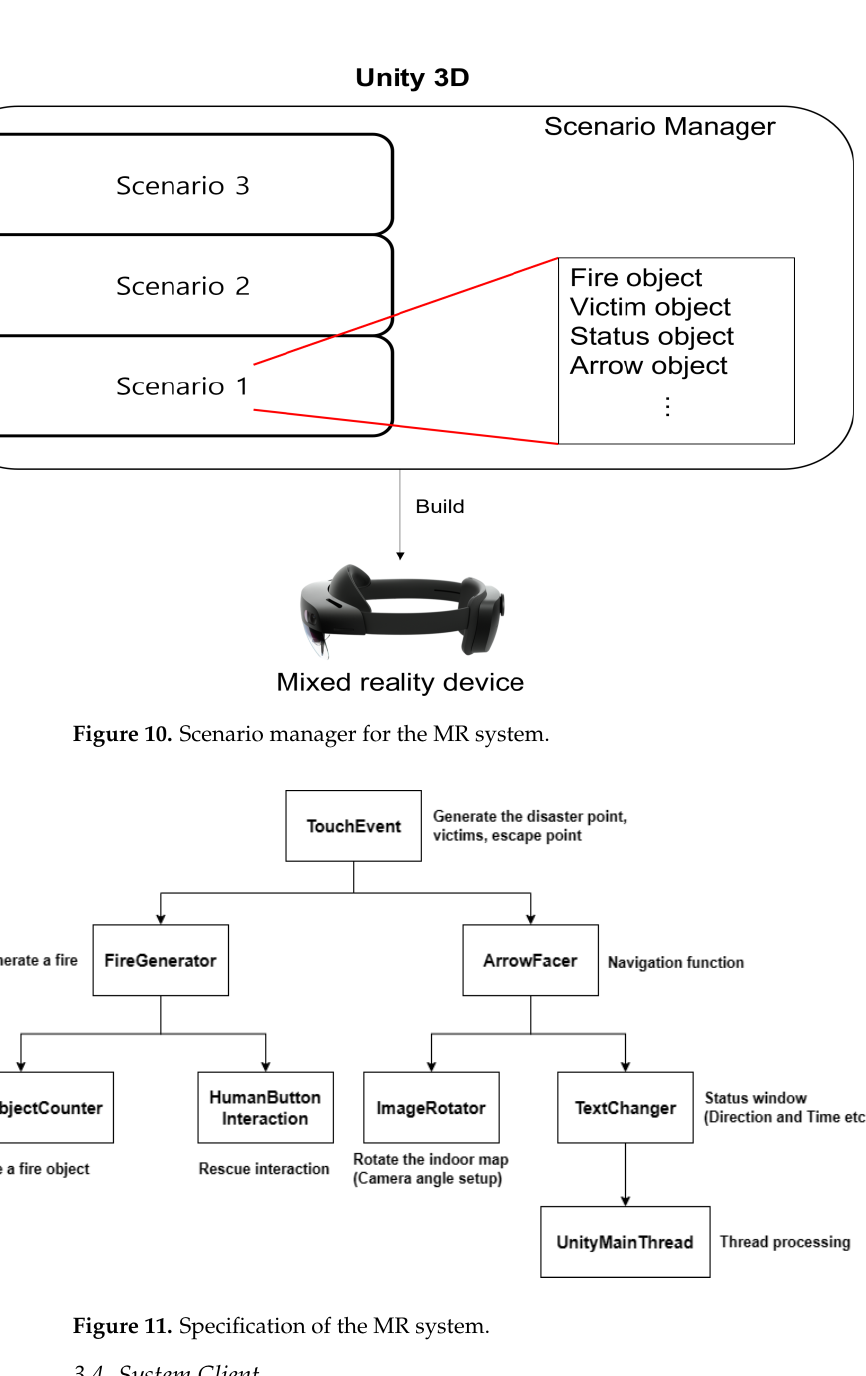
Figure 9. Schematic of the indoor virtual disaster.